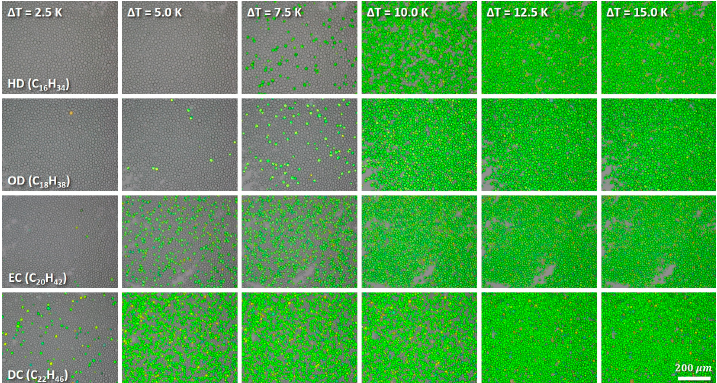
Figure 2. Micrographs of 1 wt % alkane dispersions at different supercooling with a cooling rate of 1 K/min. Length of the scale bar is 200 µm.